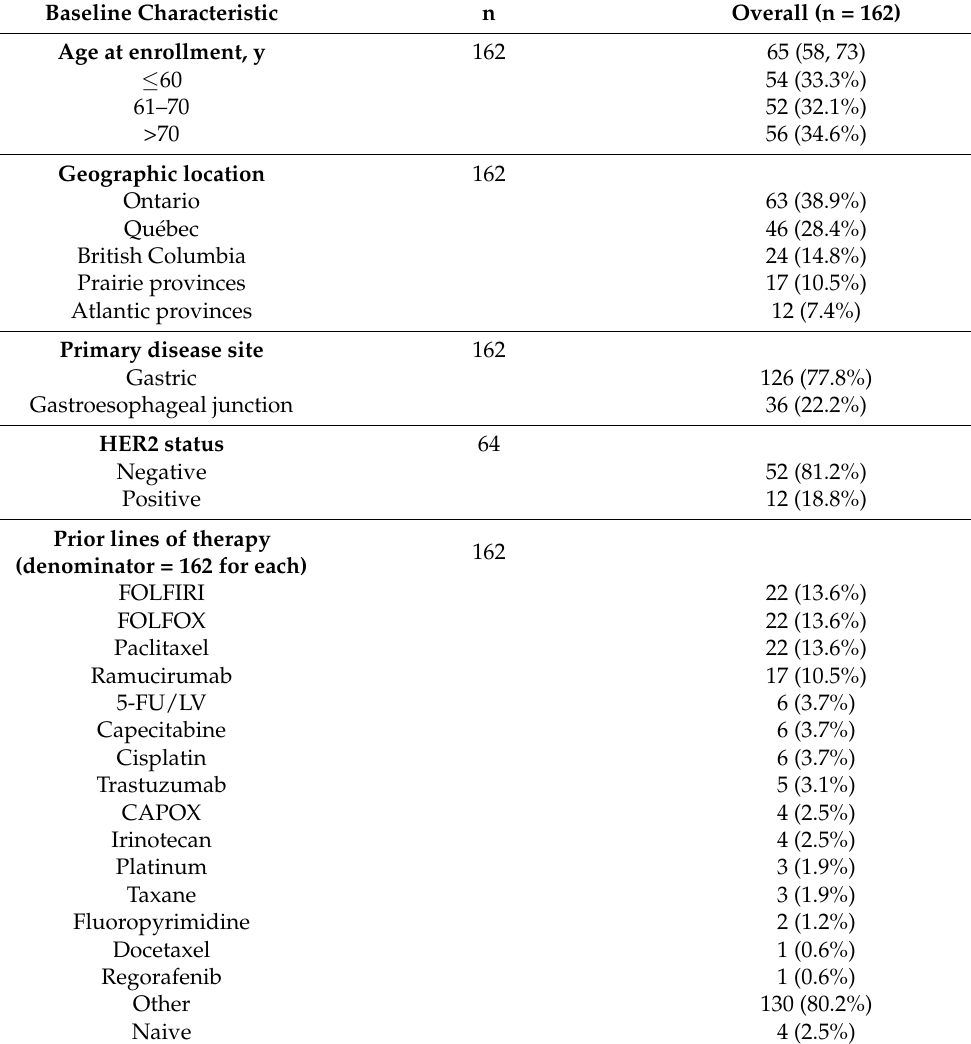
Baseline demographic and clinical characteristics of patients enrolled in Taiho Pharma Canada’s Patient Support Program to receive trifluridine/tipiracil for metastatic gas- tric/gastroesophageal